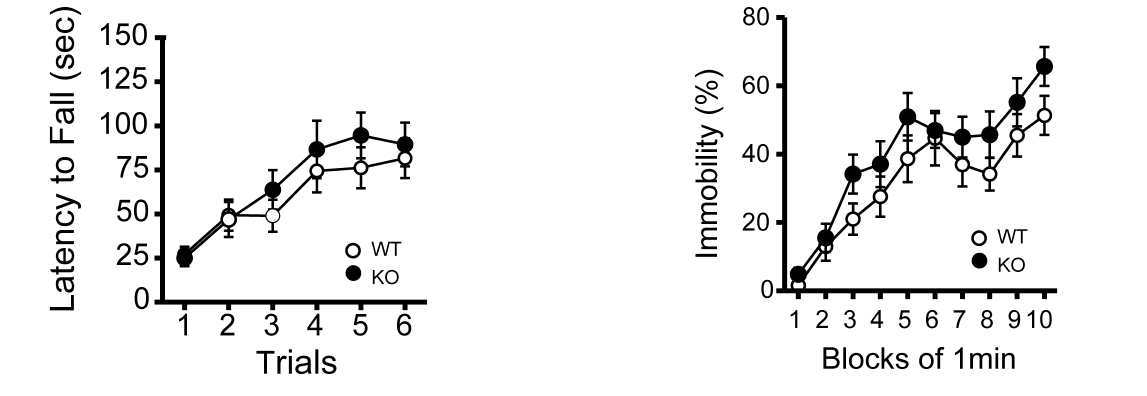
Figure 6 | Immobility in the tail suspension assay. Immobility time is pre- sented as % time in each block. There was no signifi cant differences between kf-1 + / + and kf-1 − / − in immobility in the tail suspension test ( p = 0.0855, = 3.118) (see Section ‘Tail Suspension Test’). WT and KO stand for kf-1 + / + F 1,38 and kf-1 − / − mice,